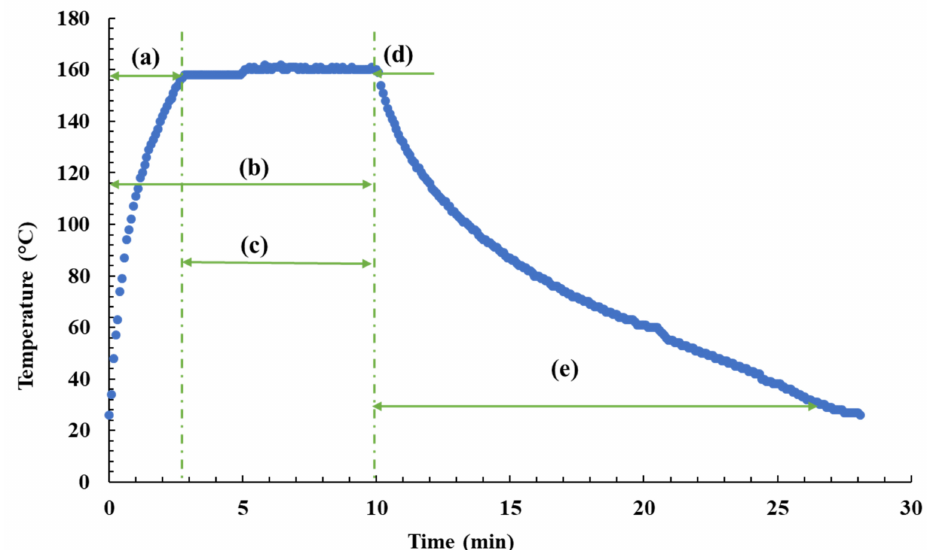
Figure 9. Temperature profile of a microwave irradiation experiment using the standard power mode: ( a ) ramp time or heating time (heating from an ambient temperature to the final reaction temperature over the first 0–1 min), ( b ) total time, ( c ) reaction time, ( d ) end of hold reaction time at the desired reaction temperature, and ( e ) heat dissipation time without power